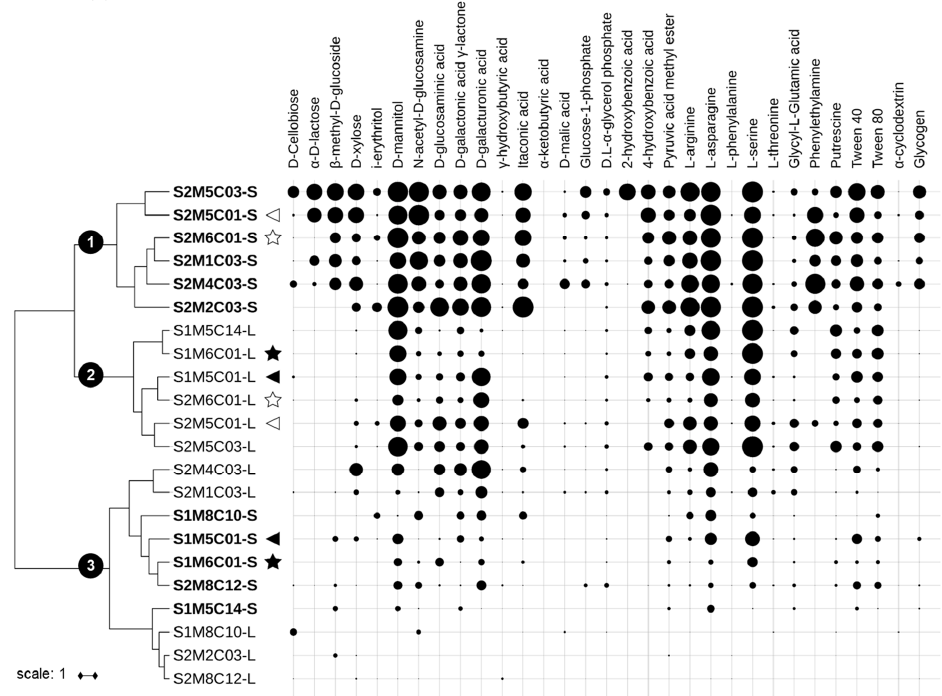
Figure 2. Ward’s clustering based on the metabolic profiles of the lichen and substrate microbiotas. Normalized carbon consumption data at the exponential phase and Euclidean distance were used. Consumption data by each sample is shown with a circle plot for each carbon-source, and the diameter of the circle is proportional to the magnitude of consumption. The nomenclature for each composite sample indicates the site (S1 or S2), then the mycobiont (M1, M2, M4, M5, M6, or M8), then the cyanobiont (C01, C03, C10, C12, or C14) and whether it comes from lichen thallus (-L) or from the substrate (-S). Substrate samples names are emphasized in bold. M5C01 samples are indicated with triangles and M6C01 with stars. Filled triangles and stars indicate M5C01 and M6C01 samples from Site 1, whilst empty triangles and stars indicate M5C01 and M6C01 samples from Site 2.